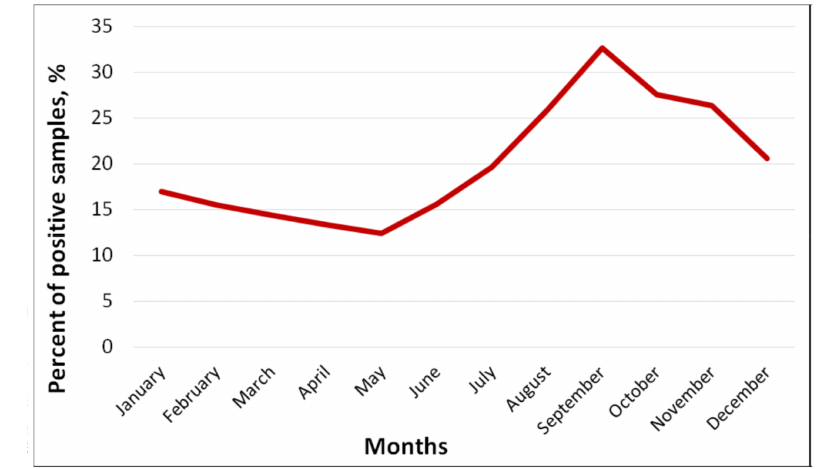
Figure 2. Seasonal frequency of isolation of enteroviruses (%) from sewage, Moscow,